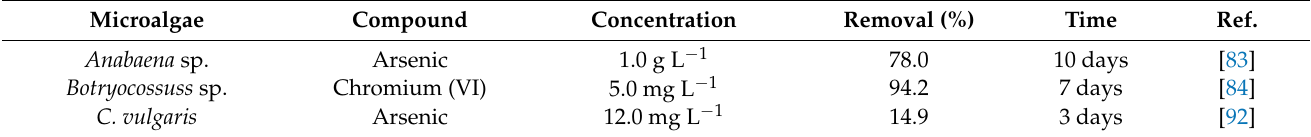
Table 5. Toxic metals removal from wastewater by microalgae. Microalgae Compound Concentration Removal (%) Time